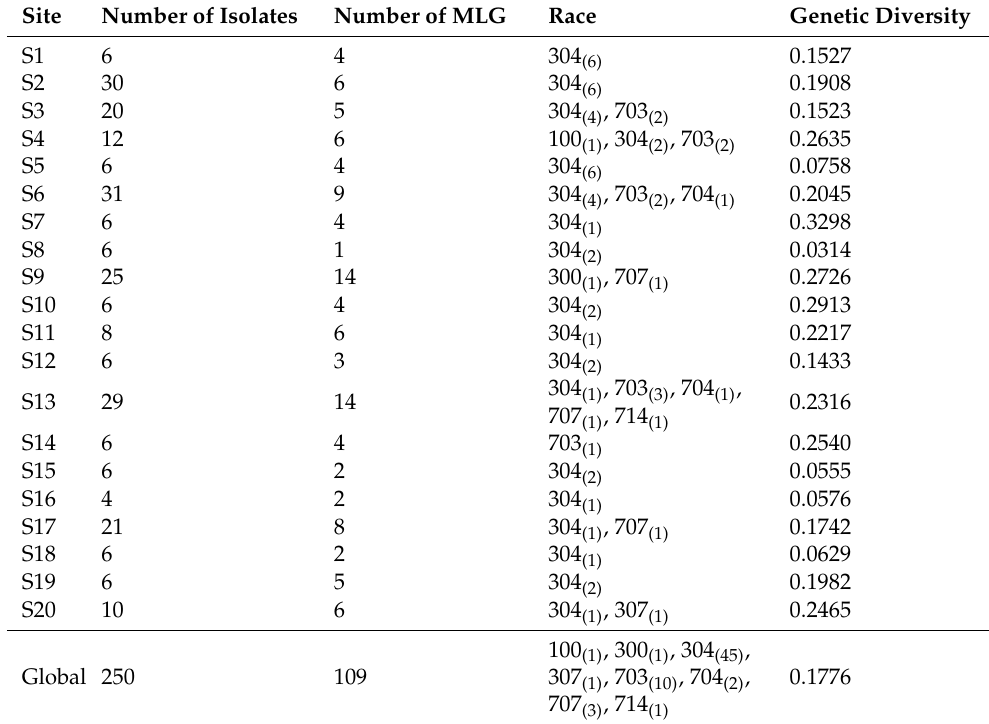
Table 3. Genetic and phenotypic characteristics of P. halstedii samples for each site (S1–S20): total number of isolates, number of MLG, races, and genetic